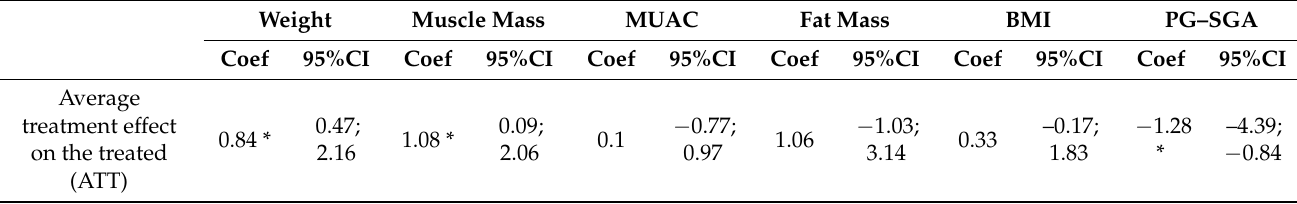
Table 4. Average treatment effect on the treated (ATT) using the propensity score matching and DiD method between pre- and post-intervention regarding several nutritional assessment indicators.